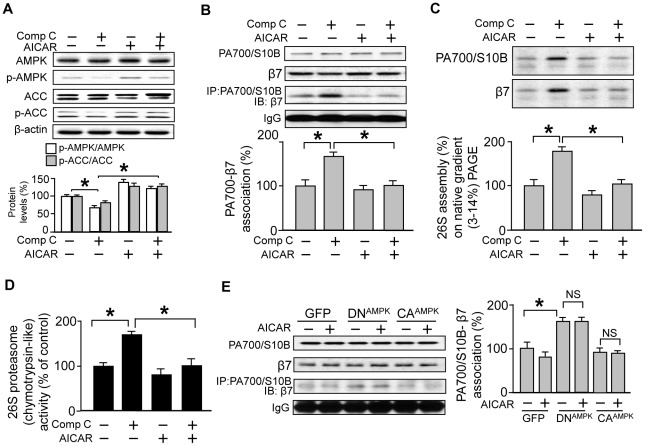
Increased 26S proteasome activity in AMPK-suppressed HUVEC is correlated with the enhanced association of 19S and 20S sub-complexes.Compound C (10 µmol/L for 2 hour)-treated HUVEC present (A) AMPK inactivation, (B) an increase in association of PA700/S10B (from 19S complex) with β7 (from 20S complex), which can be blocked by AICAR pre-incubation (2 mmol/L for 6 hours), (C) 26S proteasome assembly (same samples were run on 3–14% native-PAGE under non-reducing condition followed by conventional Western blot on duplicated blots with PA700/S10B and β7 antibodies, respectively), and (D) an increase in 26S proteasome activity (chymotrypsin-like) (n = 3). The increased association of proteasome sub-complex is also observed in (E) HUVEC overexpressing AMPK-DN but not AMPK-CA or GFP. All of the blots shown are representative of 3 independent experiments. NS represents not significant.